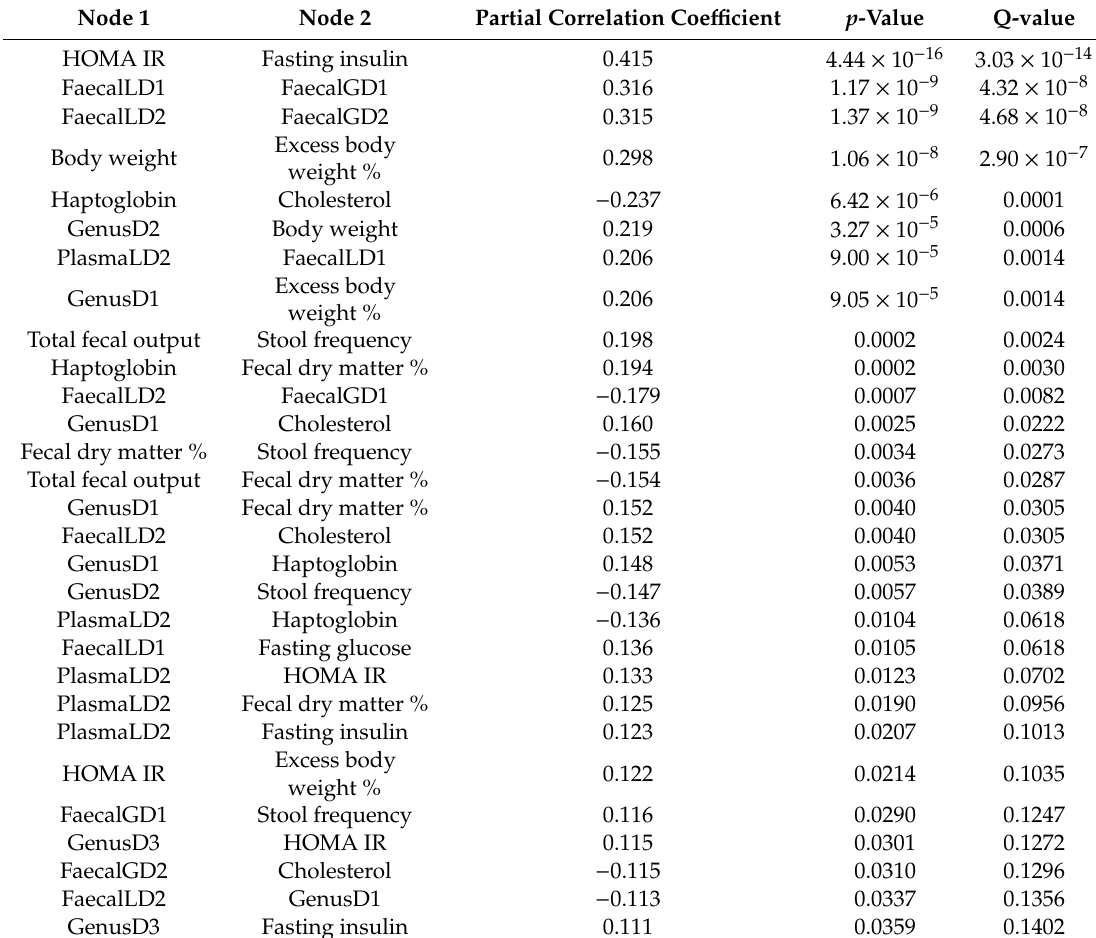
Table 8. Partial correlation coe ffi cient, p -value, and Q-value obtained between di ff erent variables and metavariables in the correlations